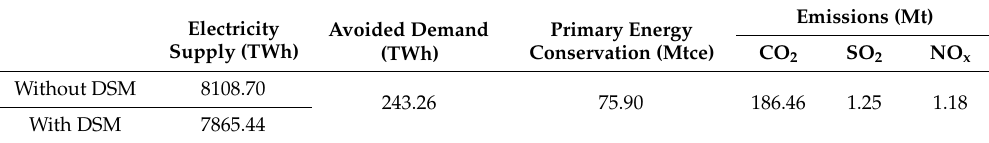
Table 10. Potential of ECER by DSM in